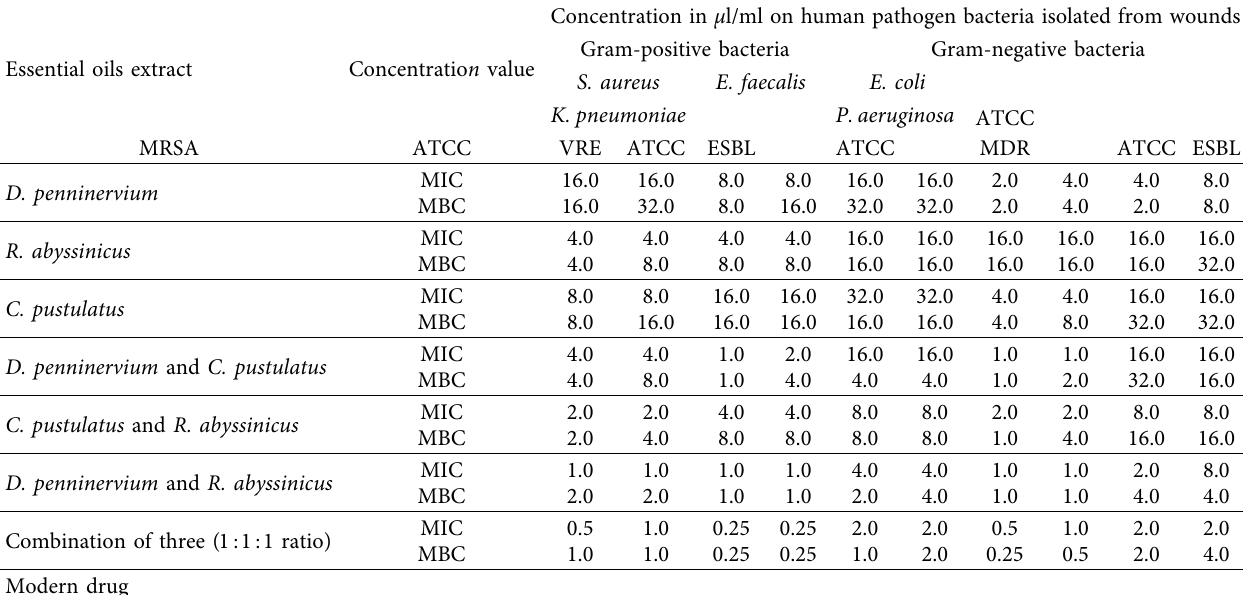
Table 4: MIC and MBC values of essential oils against human pathogenic bacteria in agar dilution method at KMU, 2020.